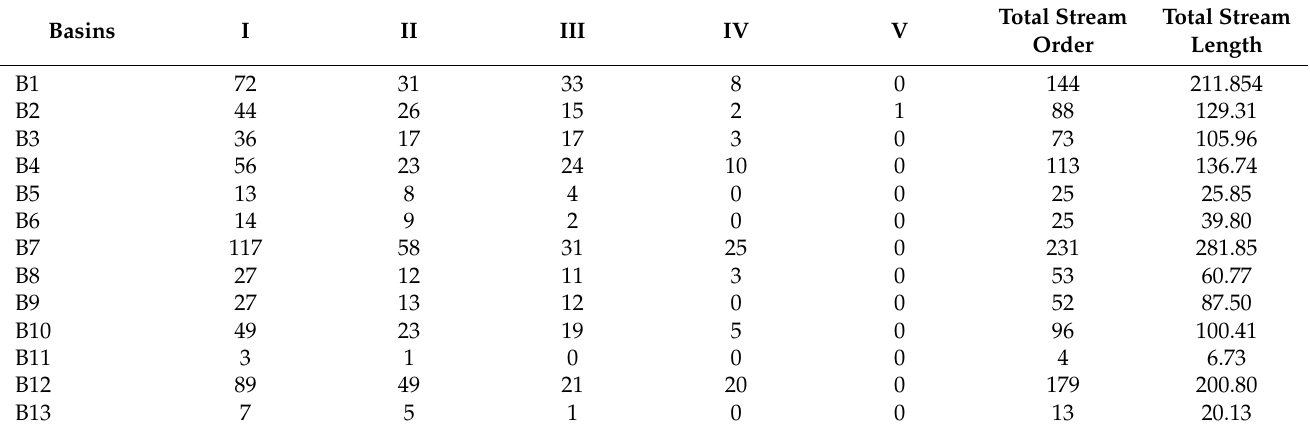
Table 4. Stream orders (Su), stream numbers (Nu), and stream lengths (Lu) of the studied basins.